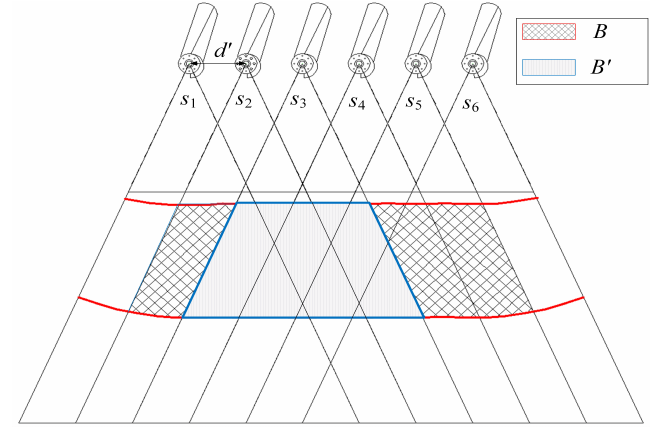
Figure 13. An example of two-barrier coverage for camera sensor